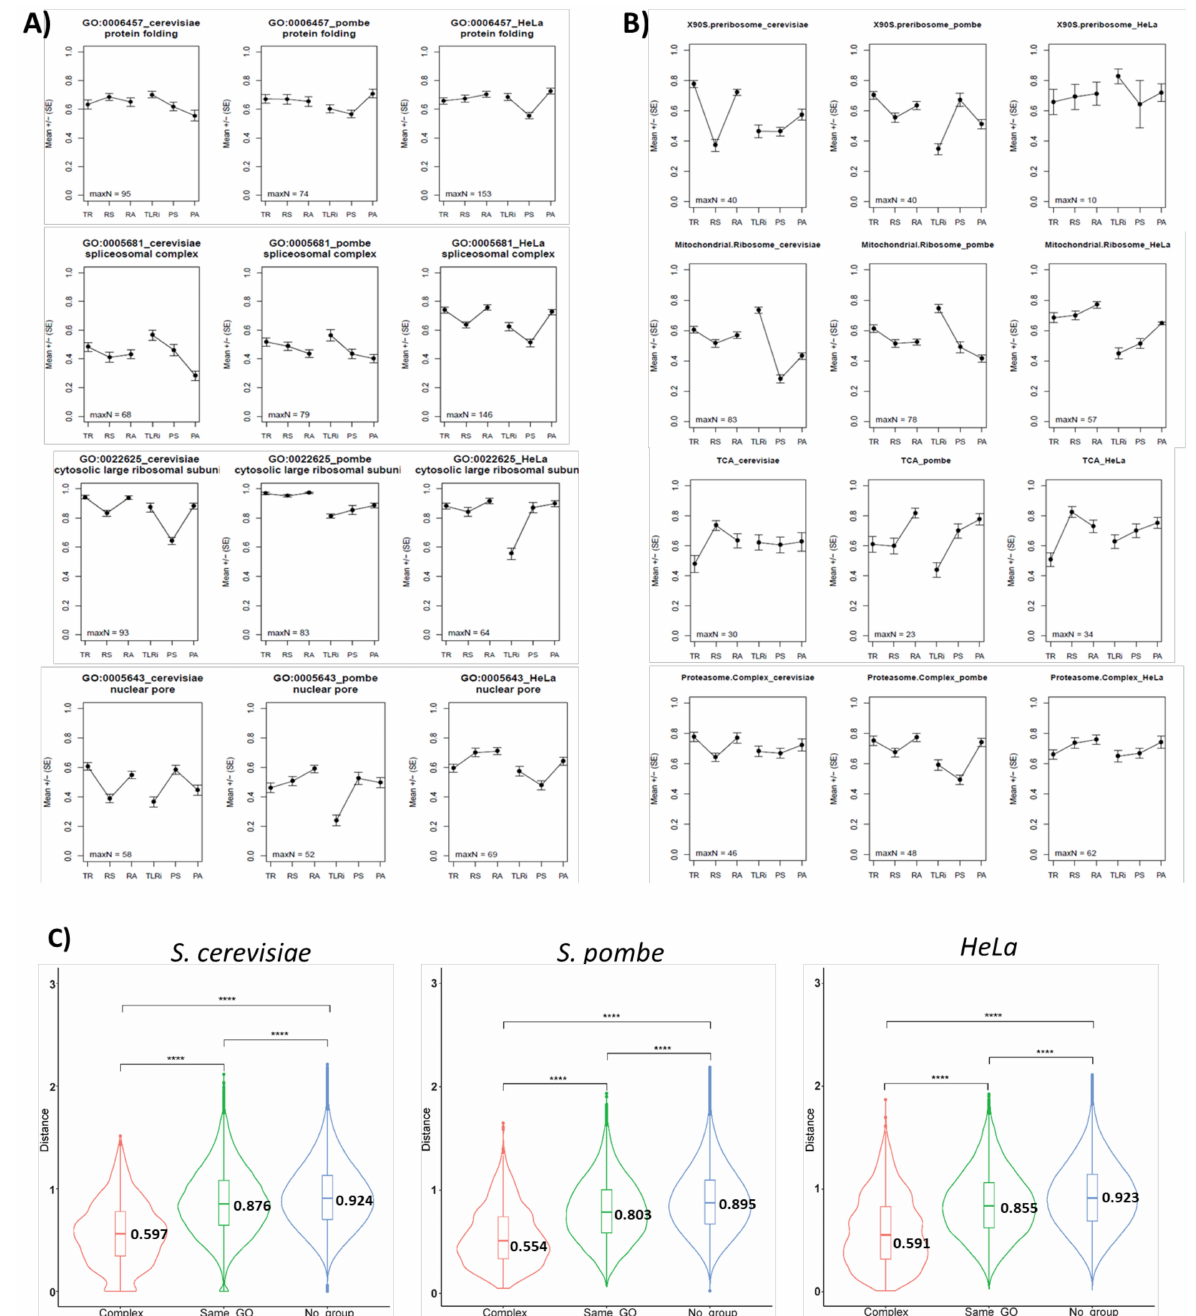
Figure 4. 6VPs for the selected GOs and manually curated groups in S. cerevisiae , S. pombe and HeLa cells. ( A ) We selected four GO terms corresponding to well-known groups of functionally related genes/proteins. The ID of the GO and its name are shown for S. cerevisiae (left), S. pombe (center) and HeLa (right). The maximum number of genes used (maxN) to determine the average value and standard error is shown. In some variables, this number may be lower due to the lack of information for some particular genes in some datasets. In this figure, unlike Figure 3, we independently represent mRNA and protein parts without a connecting line to better display the differences between them. ( B ) A similar analysis to that in ( A ), but done with the manually-curated categories that were used in a previous study on S. cerevisiae [3]. ( C ) Violin plots showing the mean of proximity (values shown on the plots) between the genes coding for the proteins acting in macromolecular complexes (Complex, red) belonging to the same GO, but do not form complexes (Same_GO, green) and other gene pairs that do not belong to the previous groups (No_group, blue). A t -test was applied for the statistical significance of the difference. **** p -value < 2.2 × 10 − 16 (lowest numerical value displayed in R). An ANOVA also detected a significant difference ( p -value < 2.2 × 10 − 16 ) among the three gene groups in all the organisms the first time they were